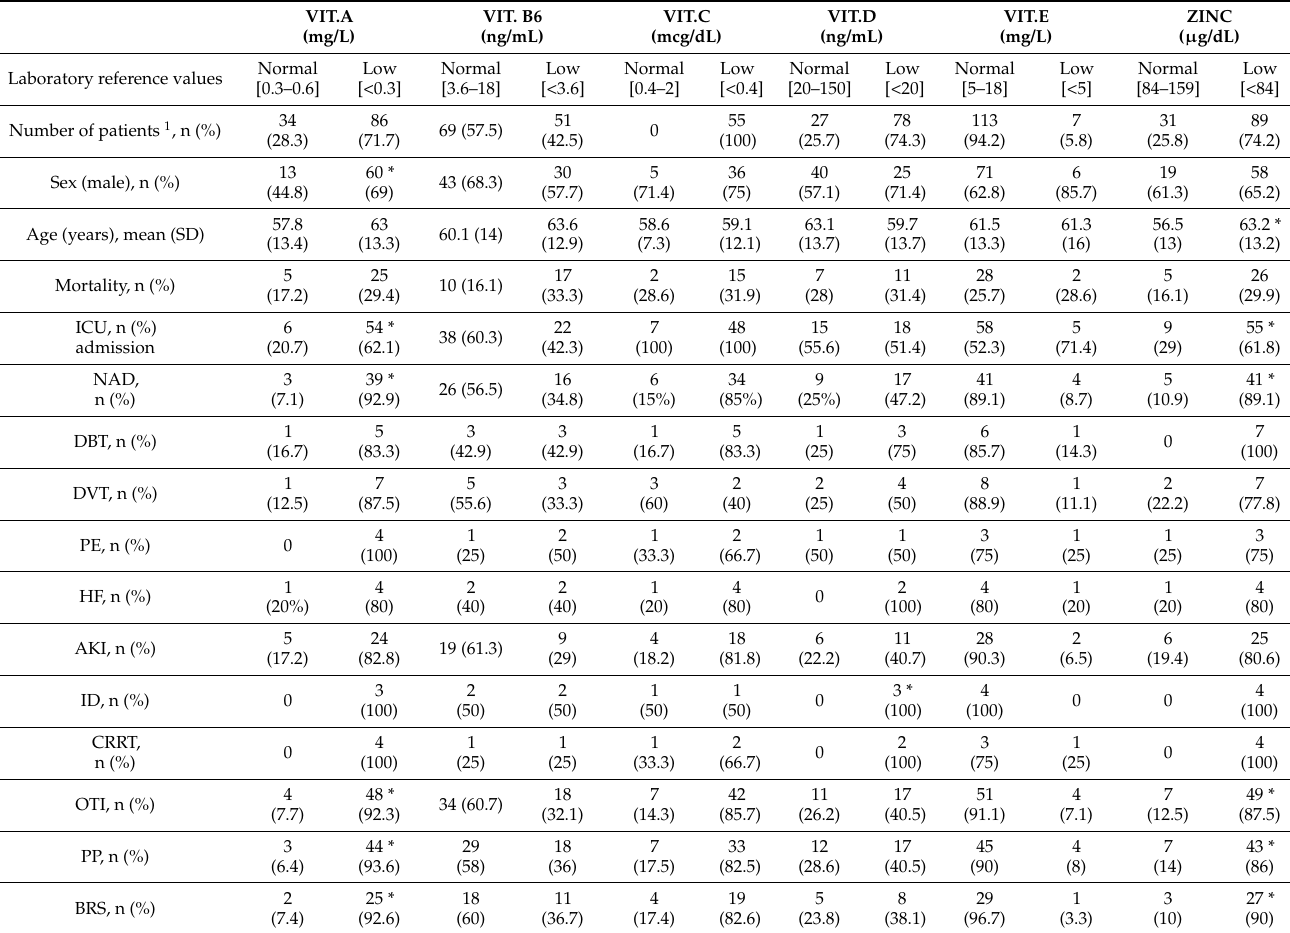
Table 2. Relevant data of patients based on their micronutrient